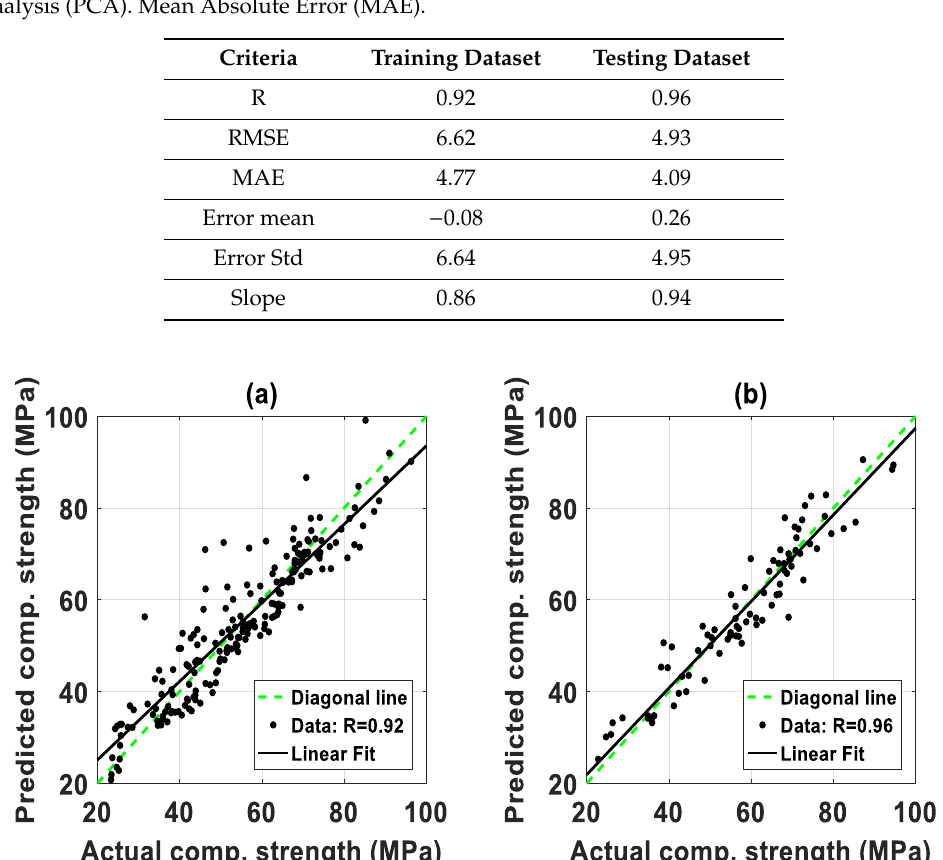
Figure3. RegressiongraphsofANFIS-TLBO / Pmodelfor( a )trainingand( b )testingdataset,respectively. Figure 3. Regression graphs of ANFIS-TLBO/P model for ( a ) training and ( b ) testing dataset, respectively.